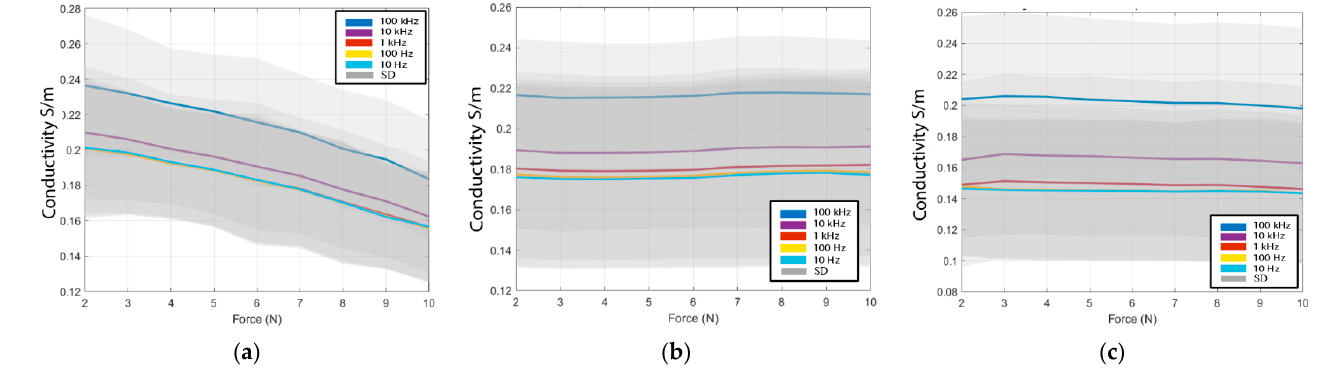
Figure 4. The average variation of the conductivity with the contact force for ( a ) forward experiment ( b ) reverse experiment ( c ) hyperhydration experiment plus the standard deviation (grey cloud) trend at 10 Hz, 100 Hz, 1 kHz, 10 kHz, and 100 kHz.